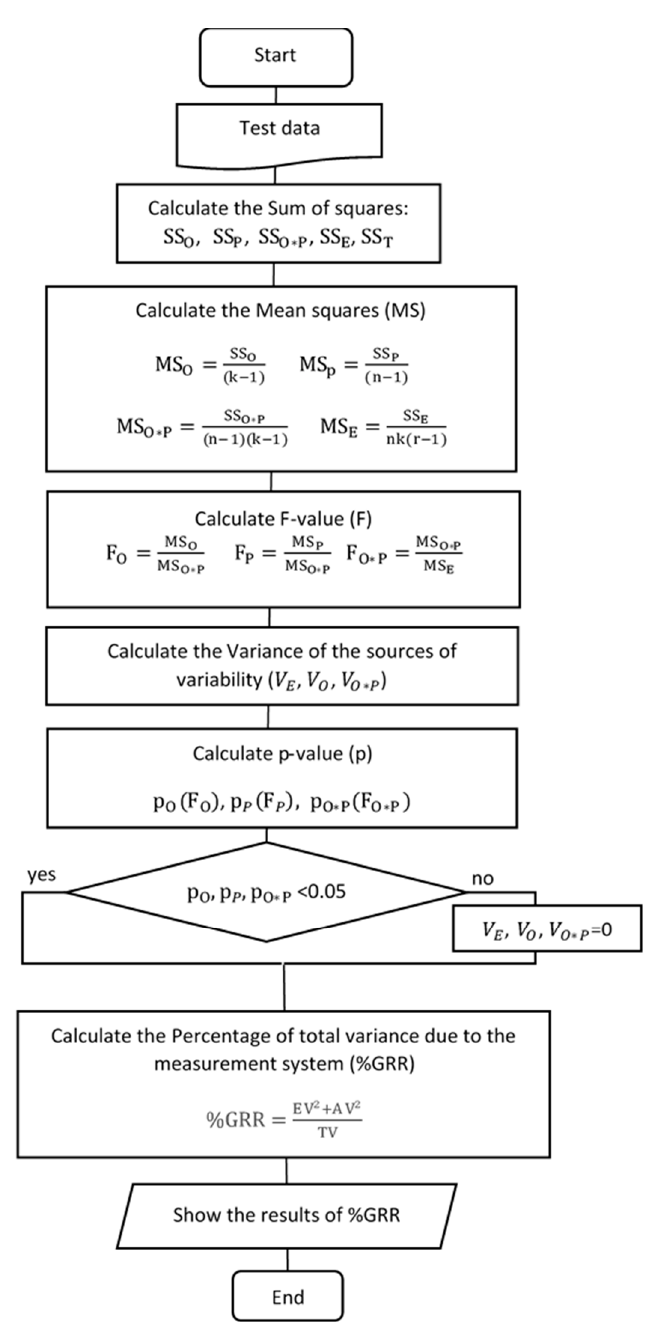
Figure A2. Procedure followed by the R&R program. where: k = number of operator; r = number of replications; n = number of part; SS = sum of squares; MS = Mean square; F = F value; P = p value; V = variance; GRR = total variance due to the measurement system; %GRR = percentage of the total variance due to the measurement system. Sub index notation: O = operator; P = part; O*P = operator by part; E = equipment; T= total.